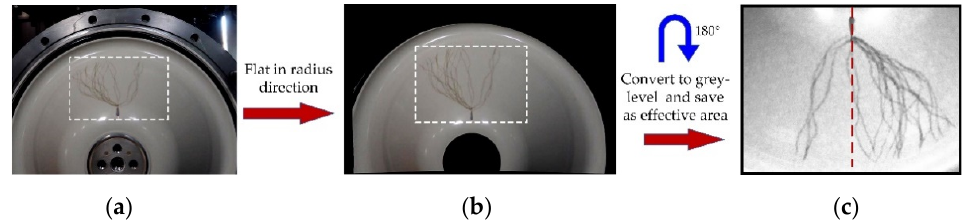
Figure 4. Conversion of tracking from original image to flatted gray ‐ level image. In ( a , b ) the cap ‐ tured image is first flatted in radius direction and enlarged to reduce perspective effect based on sample structure. In ( c ) the flatted image is converted to gray ‐ level and cut to M × N pixels.